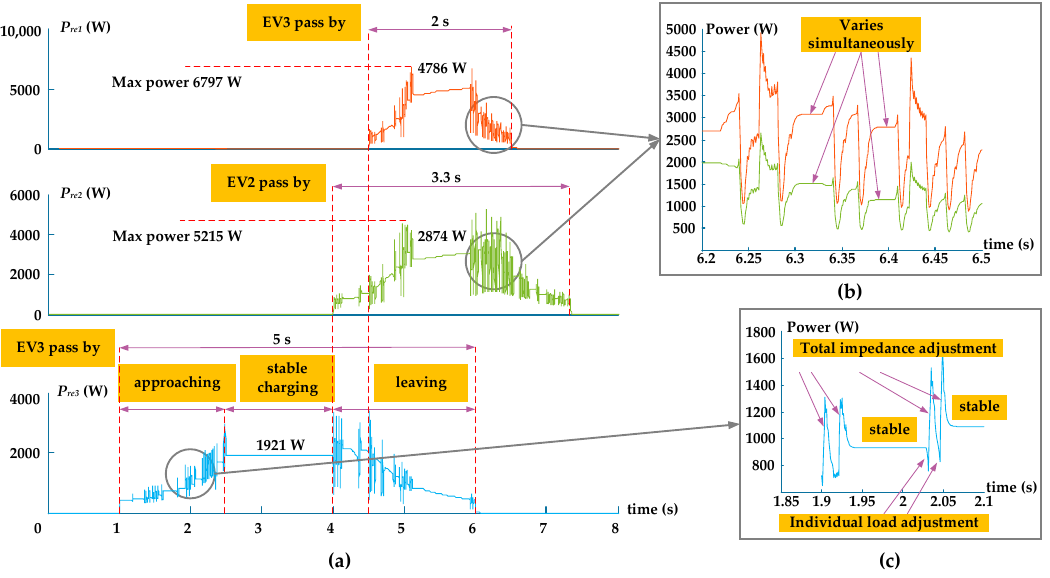
Figure 9. EV charging procedure. ( a ) Whole charging procedure. ( b ) Detailed charging procedure of power fluctuation. ( c ) Detailed procedure in power demand variation.